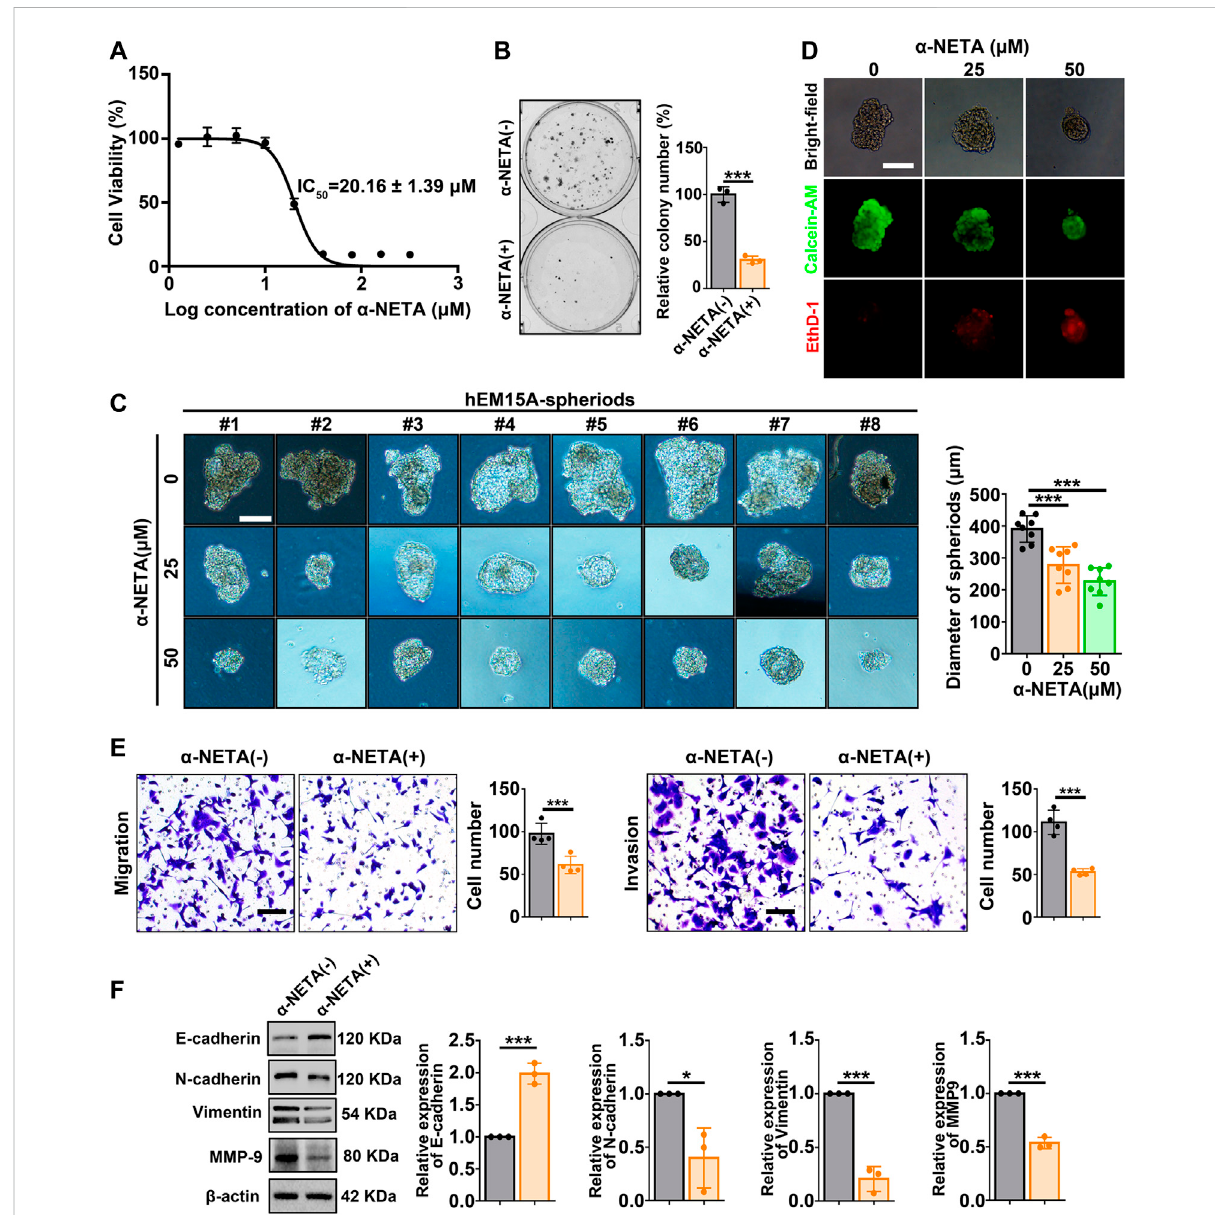
FIGURE 4 Effects of α -NETA on hEM15A-spheroids and hEM15A cells. (A) hEM15A cells were exposed to increasing concentrations of α -NETA for 24 h, a CCK-8 assay was used to access the cell viability, and the IC 50 was calculated. (B) Clone formation assay of hEM15A cells treated without or with 25 μ M α -NETA. (C) Representative images of hEM15A-spheriods treated with α -NETA (25 and 50 μ M) for 48 h. The diameter of spheroids was recorded, and the statistical data was shown in the diagram. (D) Representative images of hEM15A-spheriods stained with calcein-AM and EthD-1 after α -NETAtreatment. (E) Transwellassaywasutilizedtoevaluate cellmigrationandinvasionability,andthequantitative datawasshownin the diagrams. (F) E-cadherin, N-cadherin, vimentin, and MMP-9 expression were detected by immunoblots. Assays were performed in triplicate and thedensitometryofblotswasshown. β -Actinserved as a loading control. Scale bars, 50 μ M (C,D) and 100 μ m (E) . Data are shown as mean ± SD. * p < 0.05; ** p < 0.01; *** p <